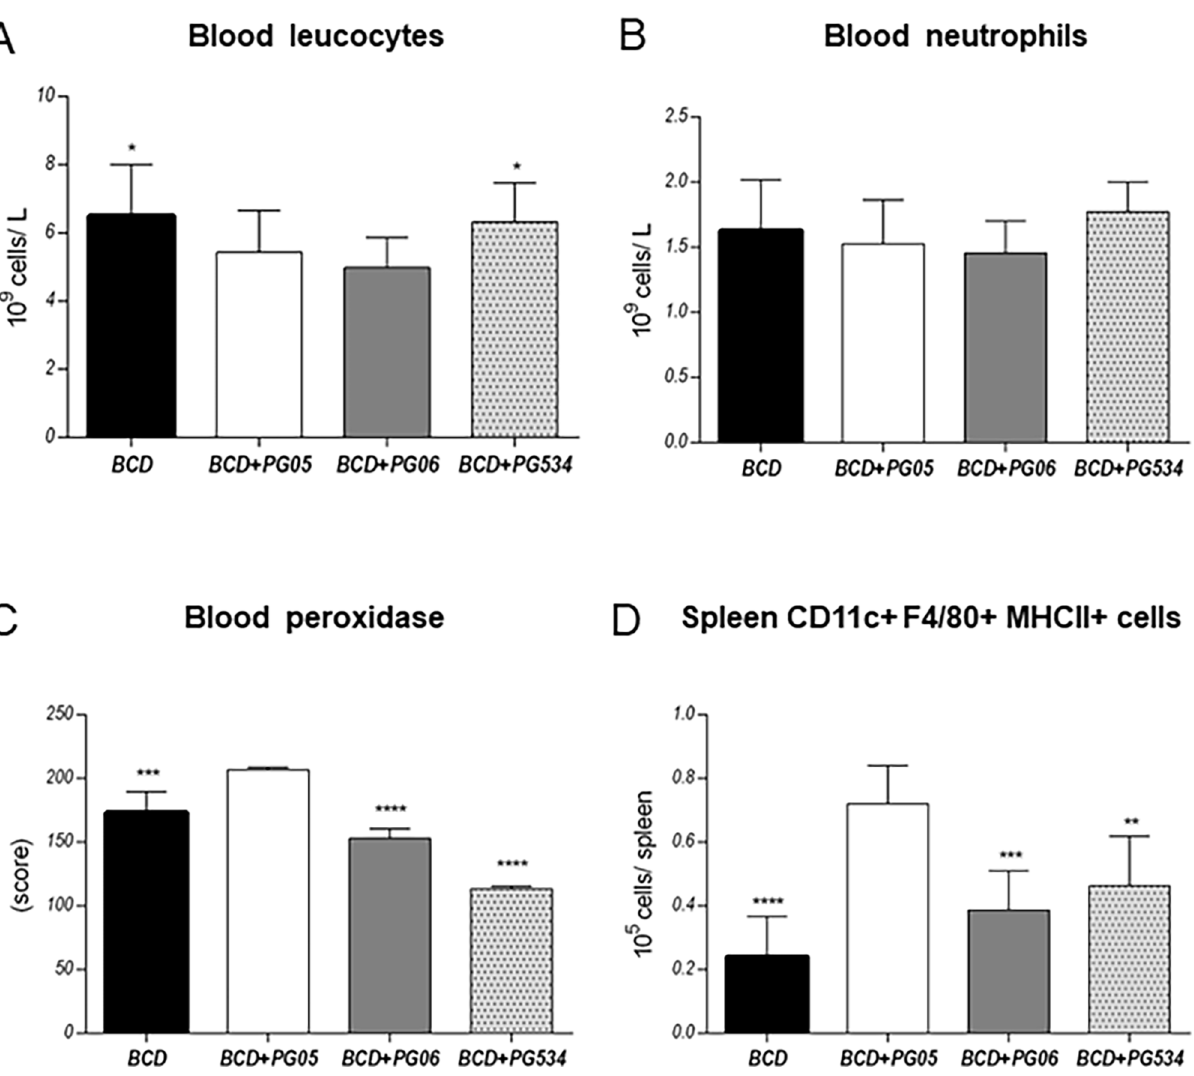
Fig 3. Effect of lactobacilli peptidoglycans on the systemic innate immune response to Streptococcus pneumoniae infection in malnourished mice. Immunocompromised-malnourished mice were replete for 7 days with a balanced conventional diet (BCD) or BCD supplemented with peptidoglycans from Lactobacillus rhamnosus CRL1505 (BCD+PG05), L . plantarum CRL1506 (BCD+PG06) or L . rhamnosus CRL534 (BCD+PG534), and then challenged with S . pneumoniae . The systemic innate immune response was studied two days after the pneumococcal challenge. (A) Number of blood leukocytes. (B) Number of blood neutrophils. (C) Score of blood peroxidase. (D) Number of spleen macrophages (CD11c + F480 + MHCII + ). Results represent data from three independent experiments. Results are expressed as mean ± SD. Asterisks represent statistical differences compared with BCD +PG05 group. (cid:3) p < 0.05, (cid:3)(cid:3) p < 0.005, (cid:3)(cid:3)(cid:3) / (cid:3)(cid:3)(cid:3)(cid:3) p (cid:20) 0.001.